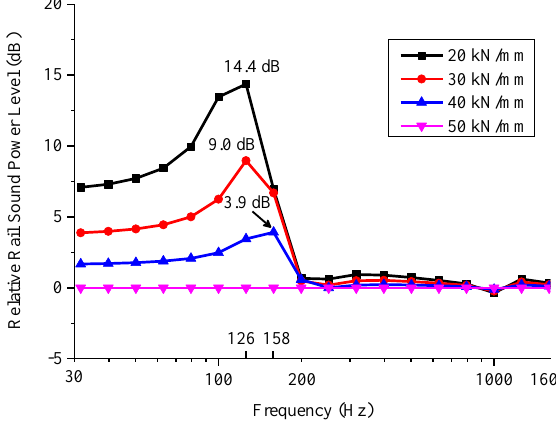
ff ness on the relative rail sound power Figure 16. Influence of vertical fastener stiffness on the relative rail sound power level. Figure 16. Influence of vertical fastener sti